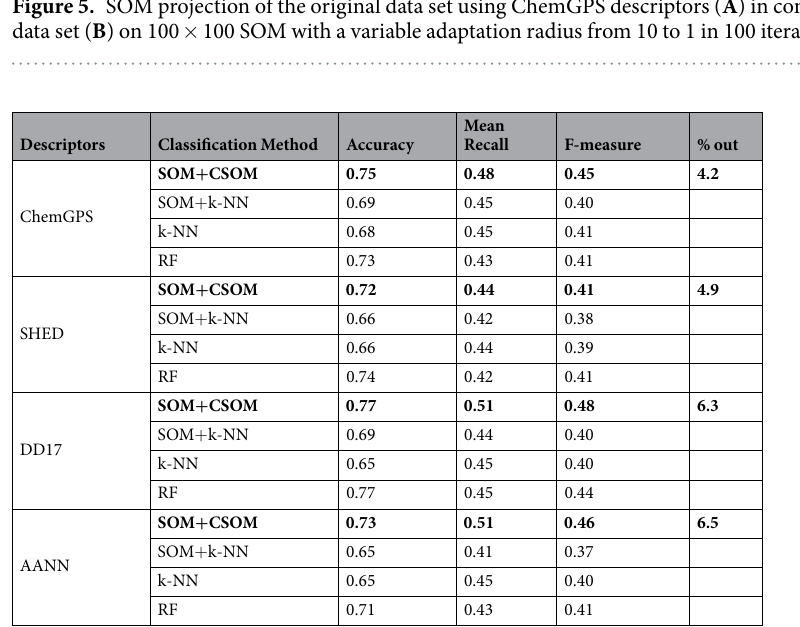
Table 4. 10-fold cross validation results obtained in the classification of ABC-transporter substrates. The use of SOM projection combined with CSOM and k-NN are compared with those obtained directly with the original dataset. For the sake of clarity, only results regarding k-NN and Random Forest (RF) are presented. In all cases SMOTE oversampling was applied. SOM topology was fixed to 100 × 100, initial adaptation radius and CSOM threshold were set to 20 and 0.9, correspondingly. The percentage of non-conclusive examples (% out) are shown when the CSOM approach is